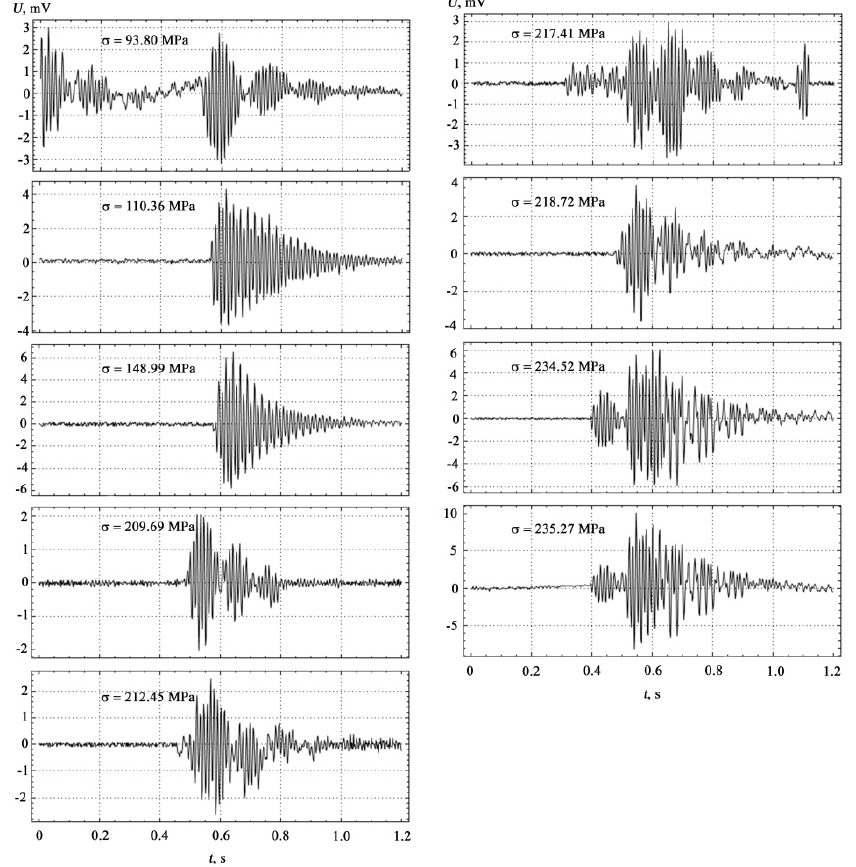
Figure 5. Results of AE measurements for the metal base of ST3sp steel. Visualization of the measurement results of coated samples at different loads is shown in Figure 6.